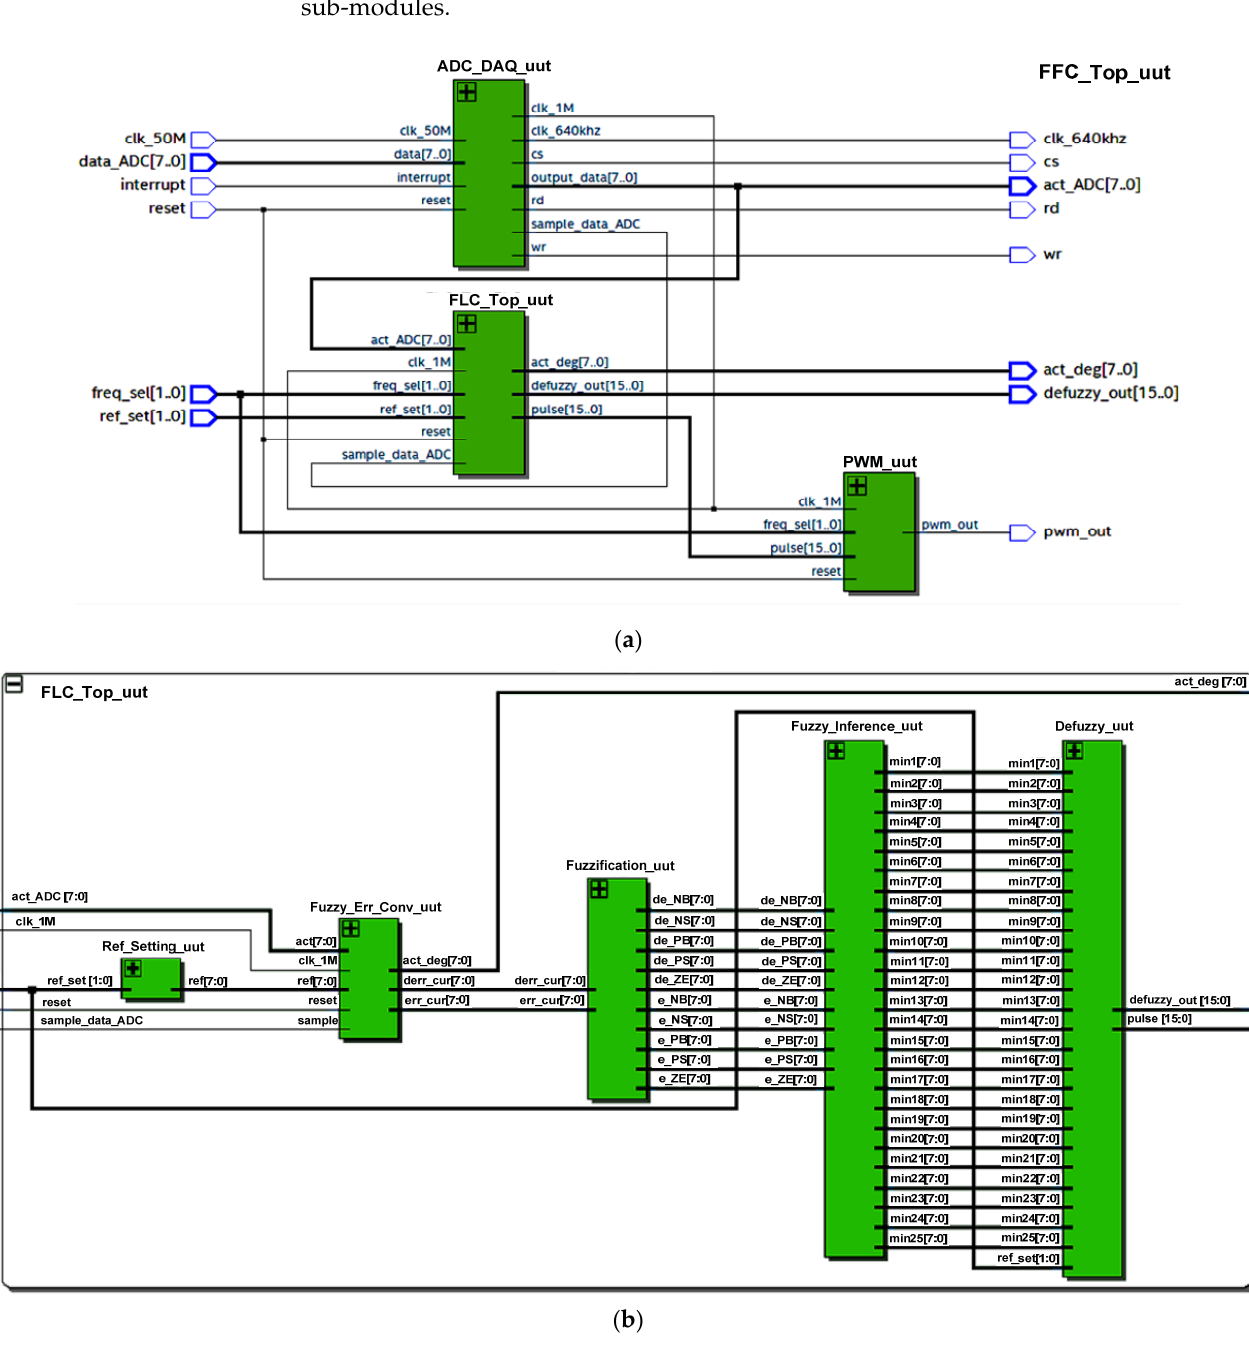
Figure 14. Schematics of the synthesized digital FFC using the Intel FPGA (Cyclone IV E) chip; ( a ) Internal architecture of the digital FFC; ( b ) Internal architecture of the digital FLC.